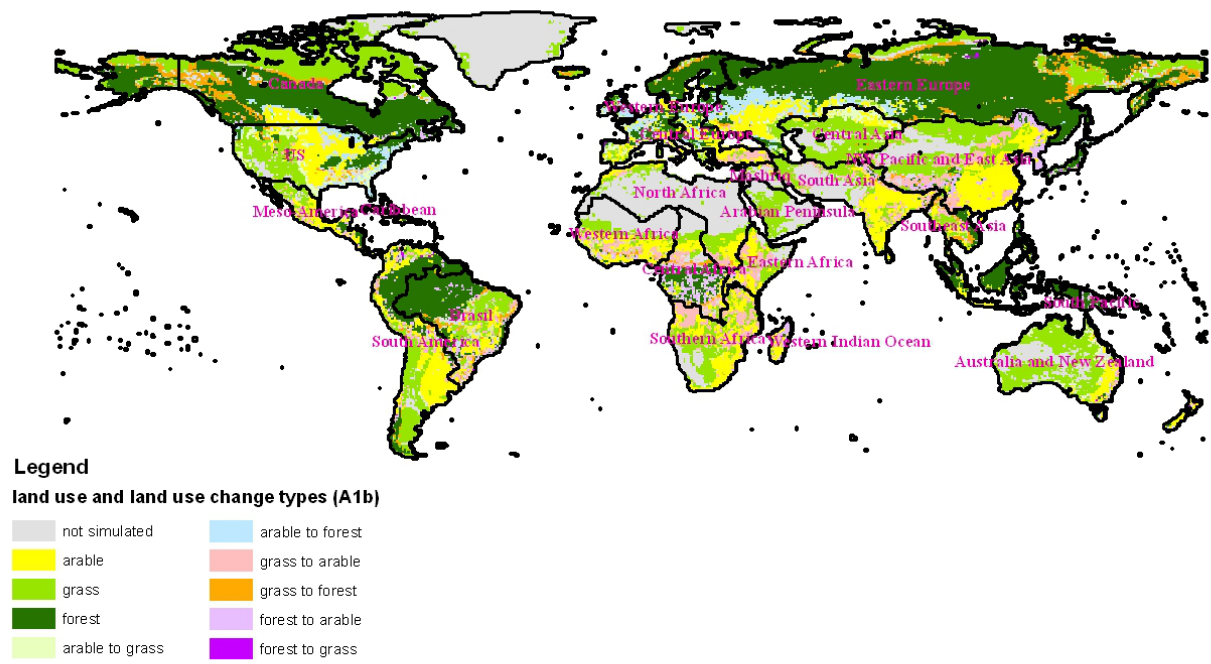
Fig. 1. Areas under the A1b scenario that are continuously covered by arable, grassland and forest from 1971 to 2100. Land use type changes from 1971 to 2100 are depicted, neglecting intermediate changes. Note that the distributions of land use and land use change under SRES B1, A2, and B2 are very similar and are not plotted separately. Relevant differences are noted in the